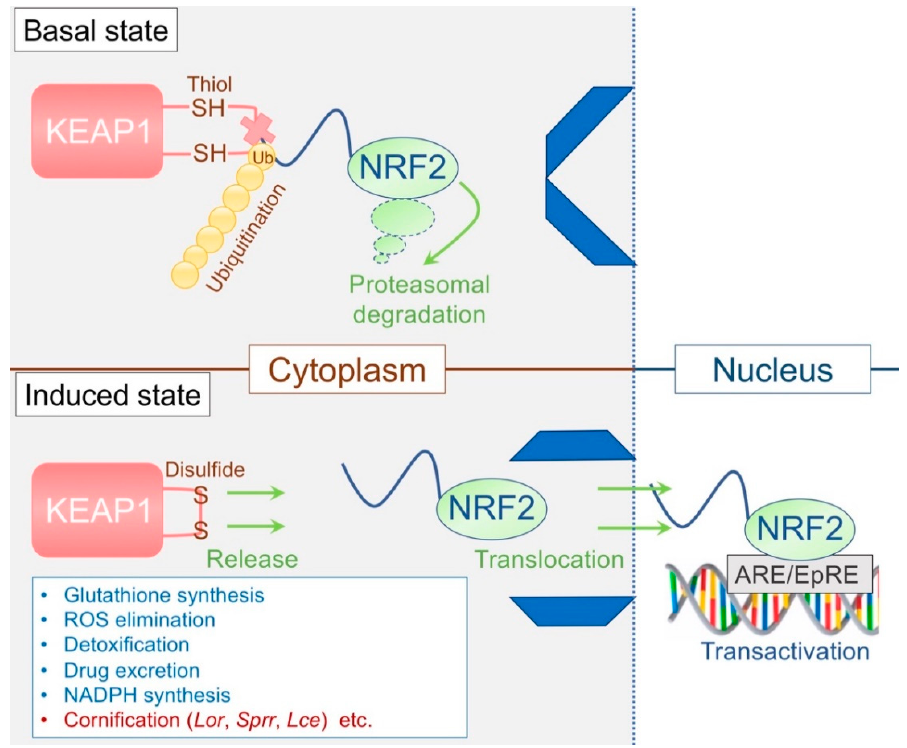
Figure 3. The basics of the Kelch-like erythroid cell-derived protein with cap´n´collar homology-associated protein 1(KEAP1) / NF-E2-related factor 2 (NRF2) system. KEAP1 acts as a “floodgate” for NRF2 and usually blocks NRF2 entry to the nucleus by facilitating its ubiquitin-mediated degradation. The gate opens upon encountering stresses, and NRF2 translocates into the nucleus and activates a battery of cytoprotective genes. Cornification is an essential aspect of such cytoprotective responses.